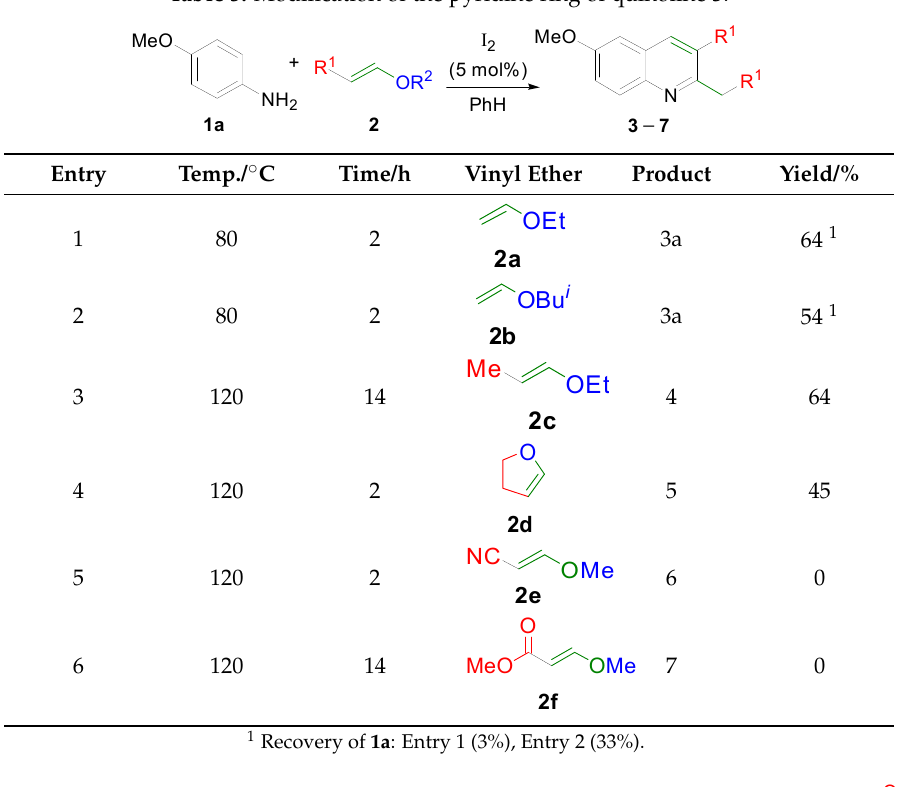
Table 3. Modification of the pyridine ring of quinoline 3 .